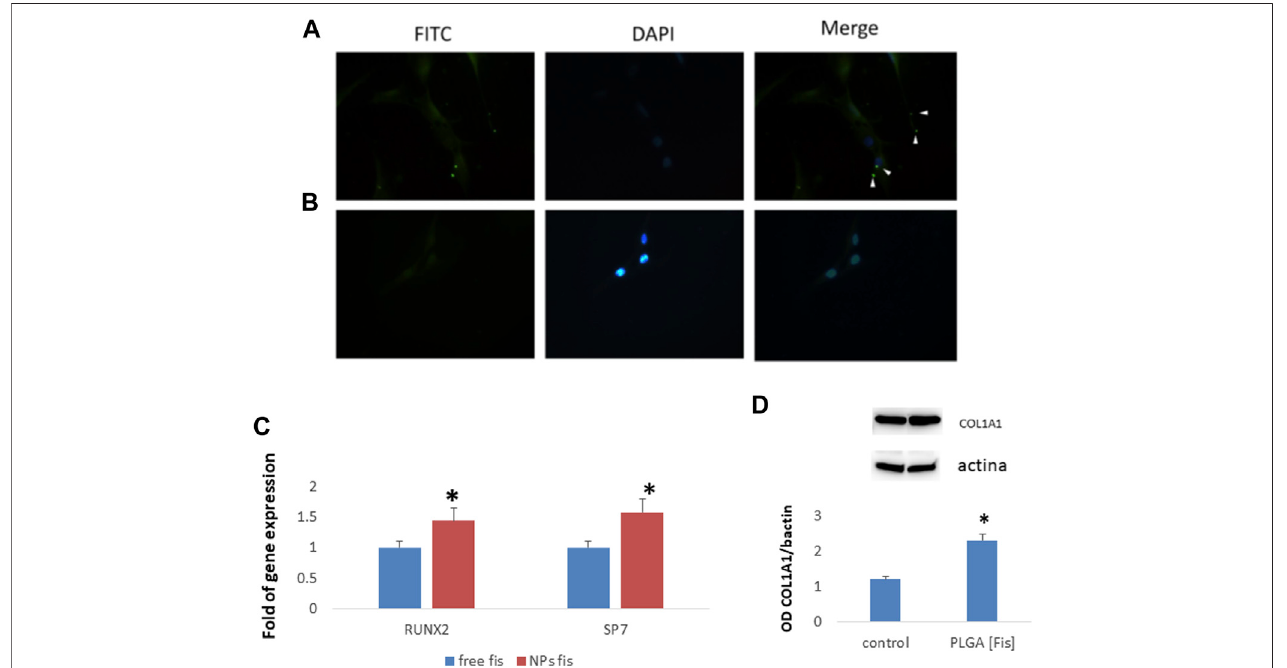
FIGURE 9 | PLGA (Fis) are visible after 4 h of treatment in cultures and fi setin (in green, FITC) diffuses in intercellular spaces (A) . However, after 6 h, fi setin is completely absorbed, and only cellular nuclei [blue, 4 ′ ,6 – diamidino-2-fenilindolo diidrocloruro (DAPI) stained nuclei] are visible (B) . After 7 days of osteogenic differentiation, PLGA (Fis) increased the expression of the osteogenic transcription factors RUNX2 and SP7 (C) . COL1A1 chain levels increased in cells treated with PLGA (Fis) compared to control (D) . * p < 0.05. Magni fi cation × 40.